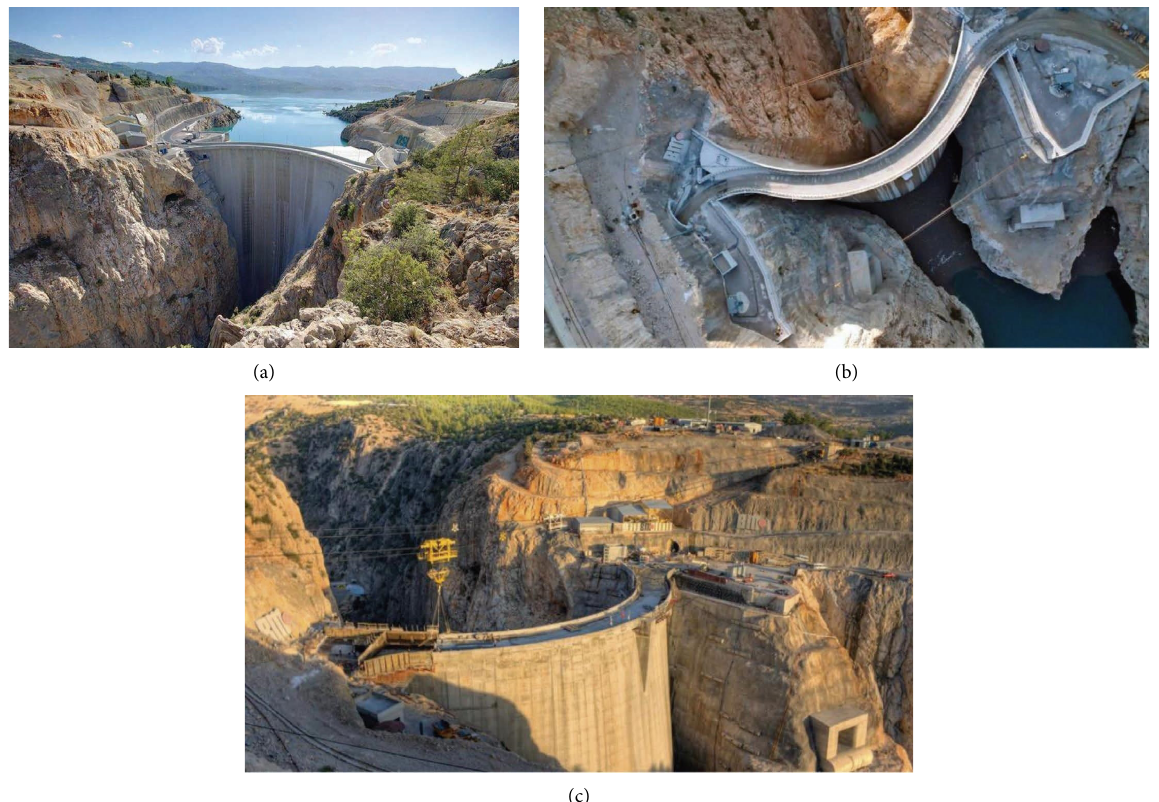
Figure 2: General view of Ermenek arch dam: (a) downstream view, (b) aerial view, and (c) upstream view [33].